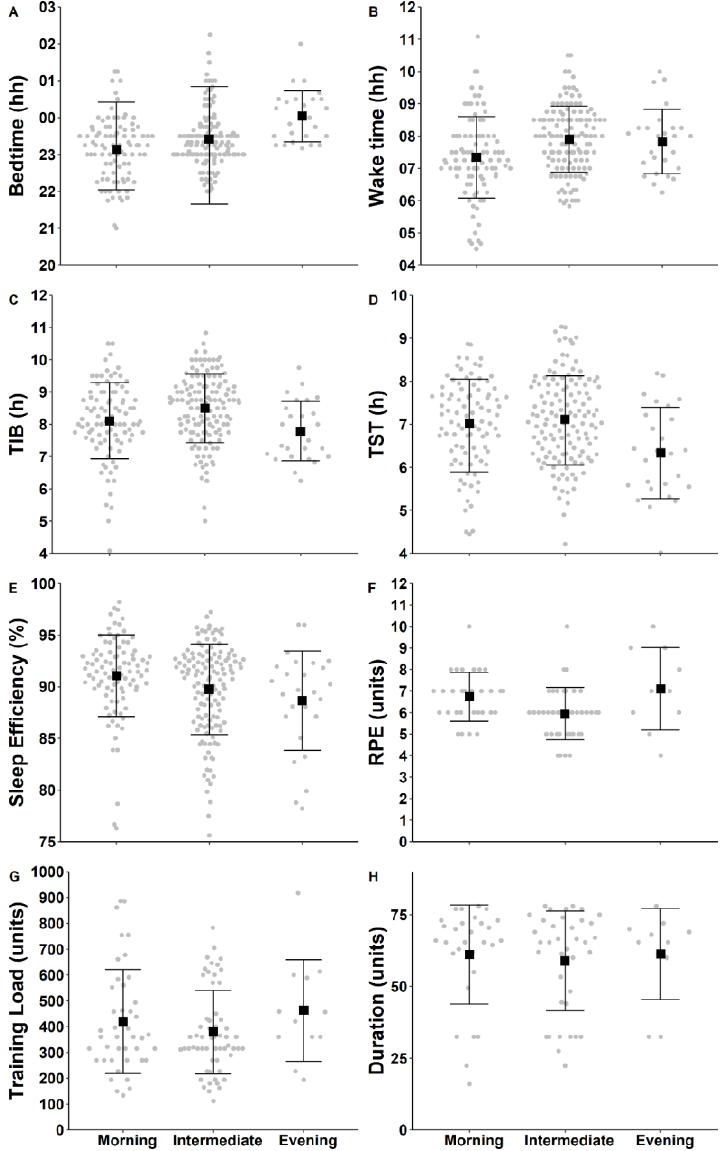
Figure 1. Individual data points for bedtime ( A ), wake time ( B ), time in bed ( C ; TIB), total sleep time